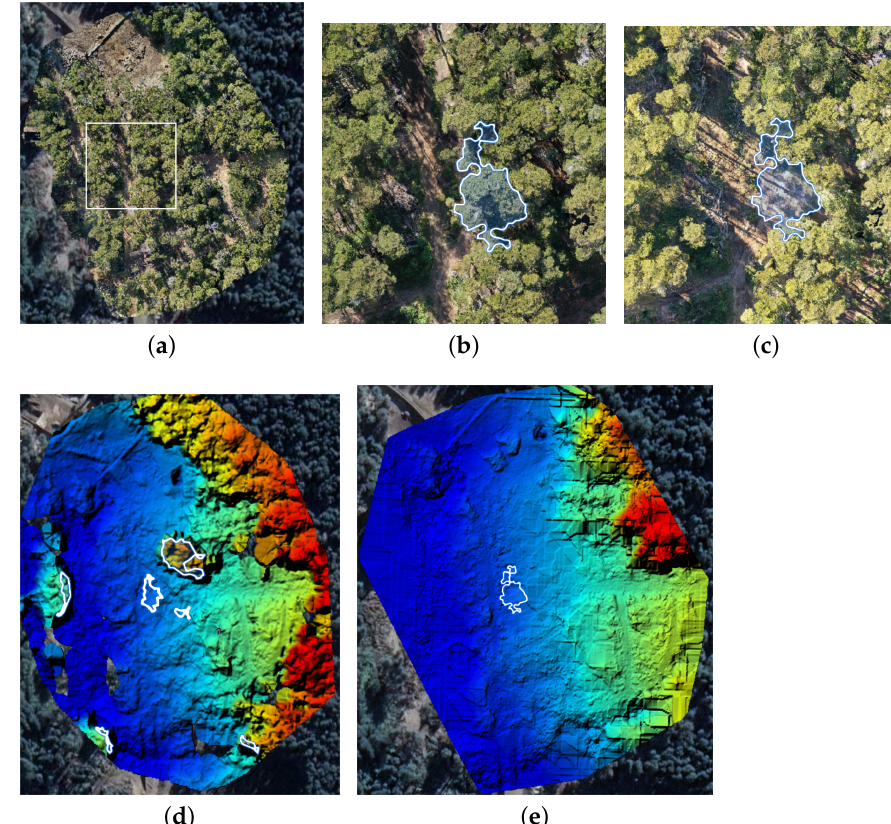
Figure 20. Selective logging detection algorithm applied over an area where some trees were cut down. ( Top left ) figure is the orthomosaic of the original area, while ( middle ) and ( right ) represent a zoom of the affected area, before and after the trees were cut down, respectively. In the ( bottom ) both DTM estimation are shown, whit the results of the selective logging detection algorithm highlighted in white. ( a ) Orthomosaic. ( b ) Zoom before cutting down. ( c ) Zoom after cutting down. ( d ) Original DTM. ( e ) Corrected